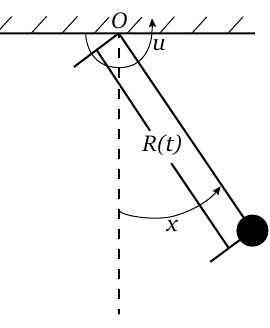
Fig. 1 The variable-length pendulum